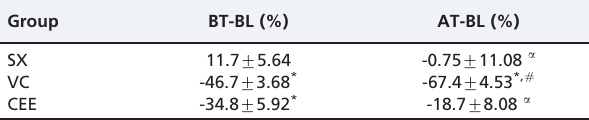
Table 1 - The percentage change in the plasma TGF- b 1